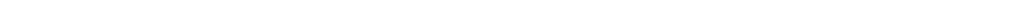
Table 2. Results from mixed models (LMM, linear mixed model; GLMM, generalized linear mixed model) analyzing. ( a ) aggression in dyadic male fights, ( b ) male sexual behavior in dichotomous choice tests, ( c ) changes in male preference expression with or without an audience male presented, and ( d ) deceptive male mating behavior with or without an audience male present. The between- ( Var